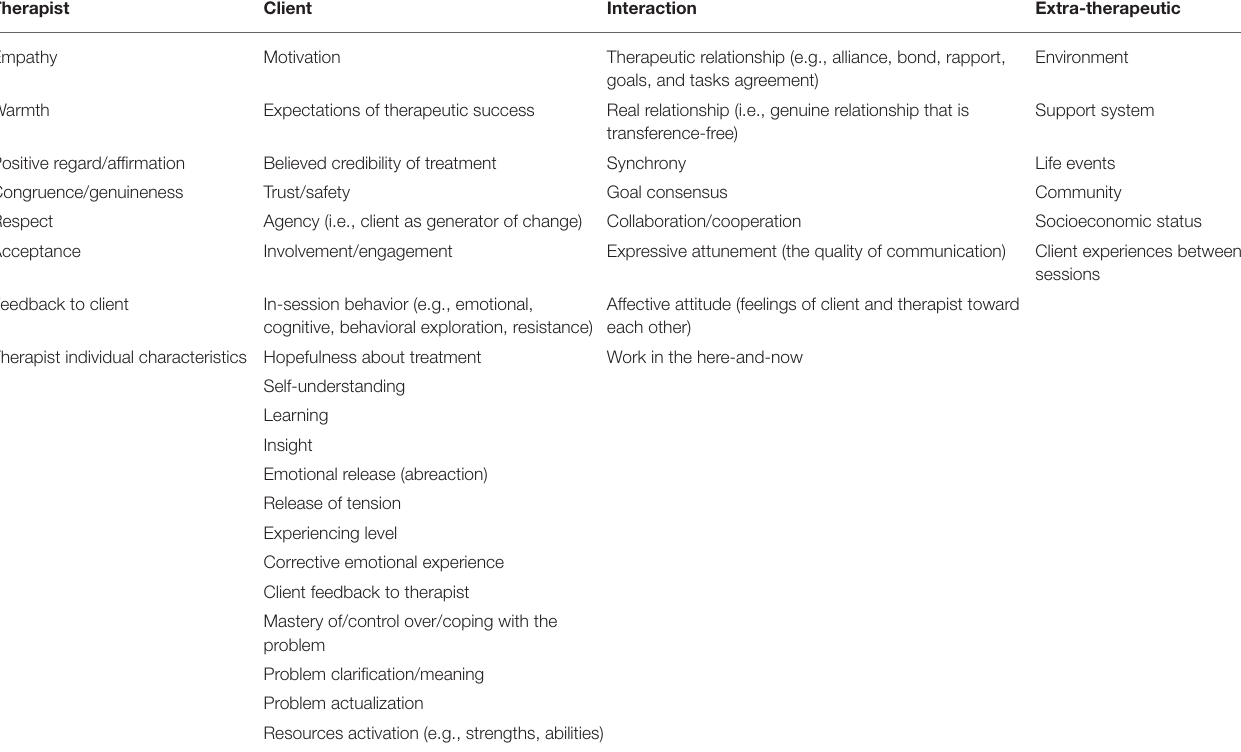
TABLE 3 | Common factors of